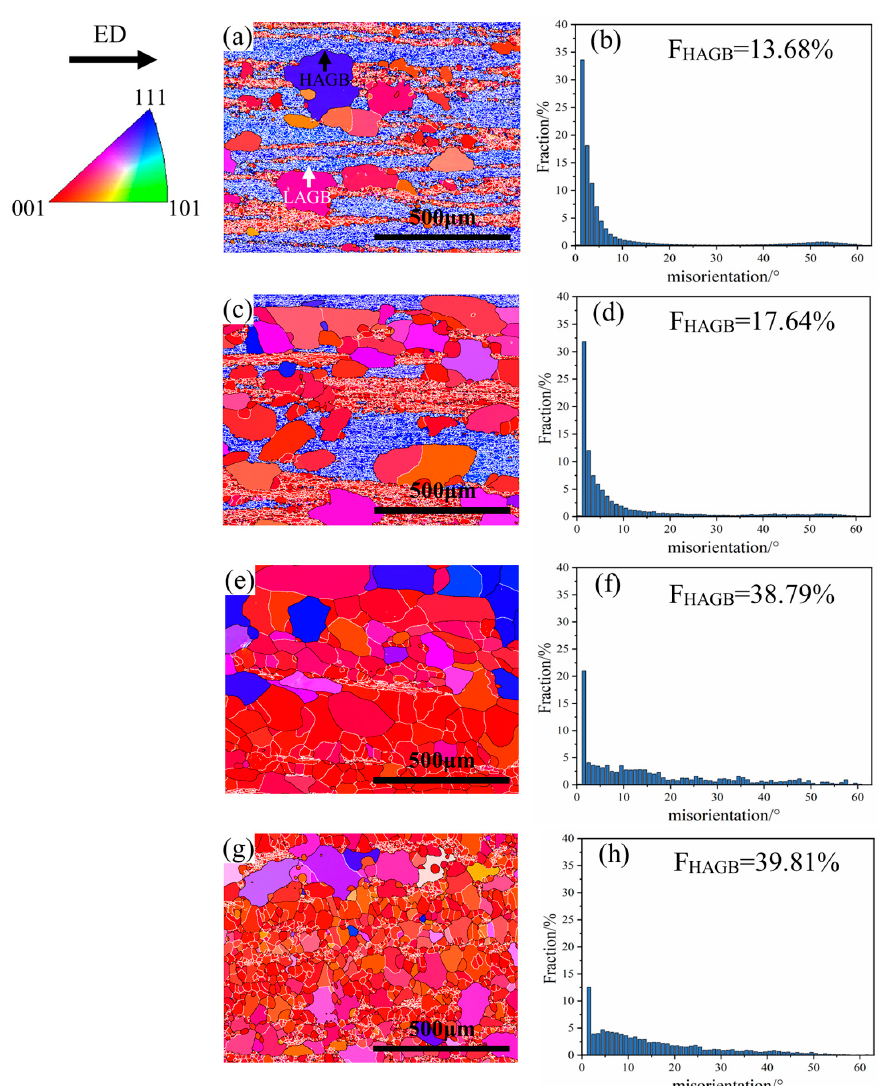
Figure 6. EBSD maps and misorientation angle distribution of specimens: ( a , b ) λ = 7, ( c , d ) λ = 13, ( e , f ) λ = 21, ( g , h ) λ = 30.